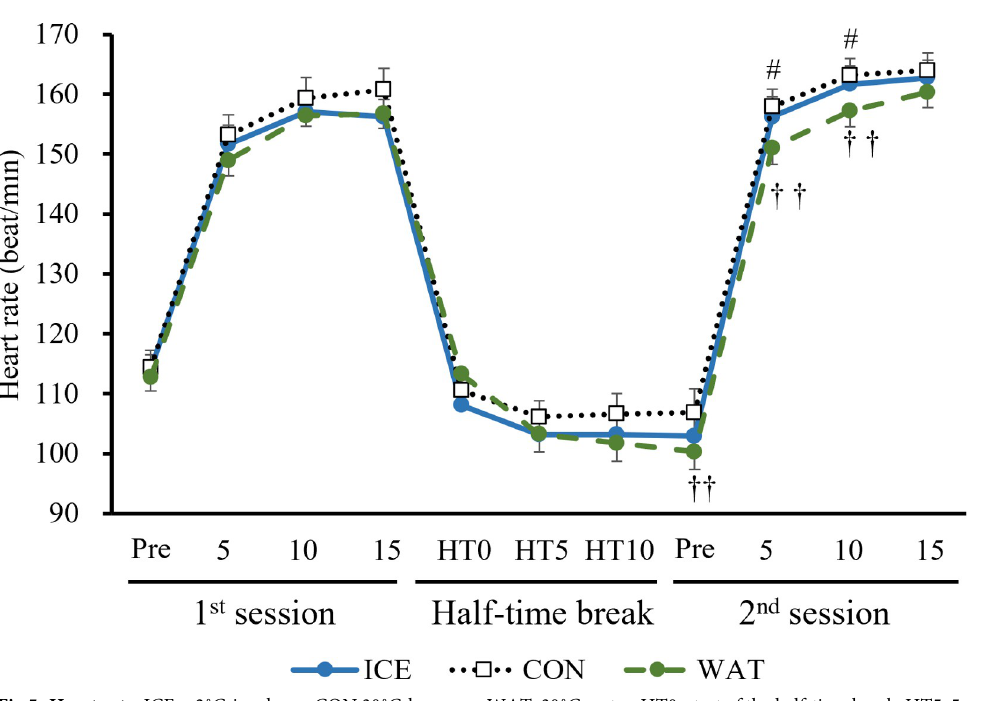
Fig 5. Heart rate. ICE: − 2˚C-ice slurry; CON:30˚C-beverage; WAT: 30˚C-water; HT0: start of the half-time break; HT5: 5 min after HT0; HT10: 10 min after HT0. Values are expressed as the means ± SE of the 12 participants. #p < 0.05 ICE vs. WAT, ††p < 0.01 CON vs.